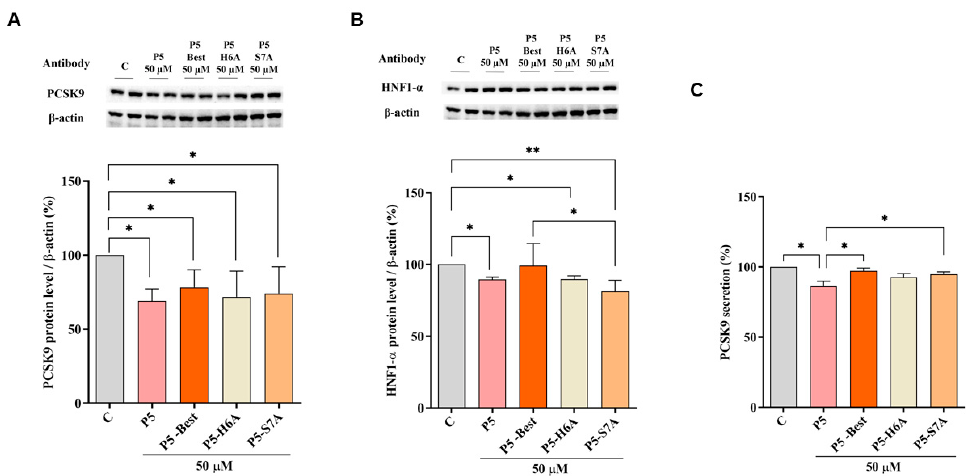
Figure 5. Modulation of the PCSK9 pathway in HepG2 cells. ( A ) Effects on the PCSK9 protein levels, ( B ) effects on the HNF1- α protein level, and ( C ) effects on mature PCSK9 secretion. Data points represent the average ± SD of six independent experiments performed in duplicate. C vs. P5 and P5 analog samples were analyzed using a one-way ANOVA, followed by by Tukey’s test; (*) p < 0.05 and (**) p < 0.001. C: control sample.